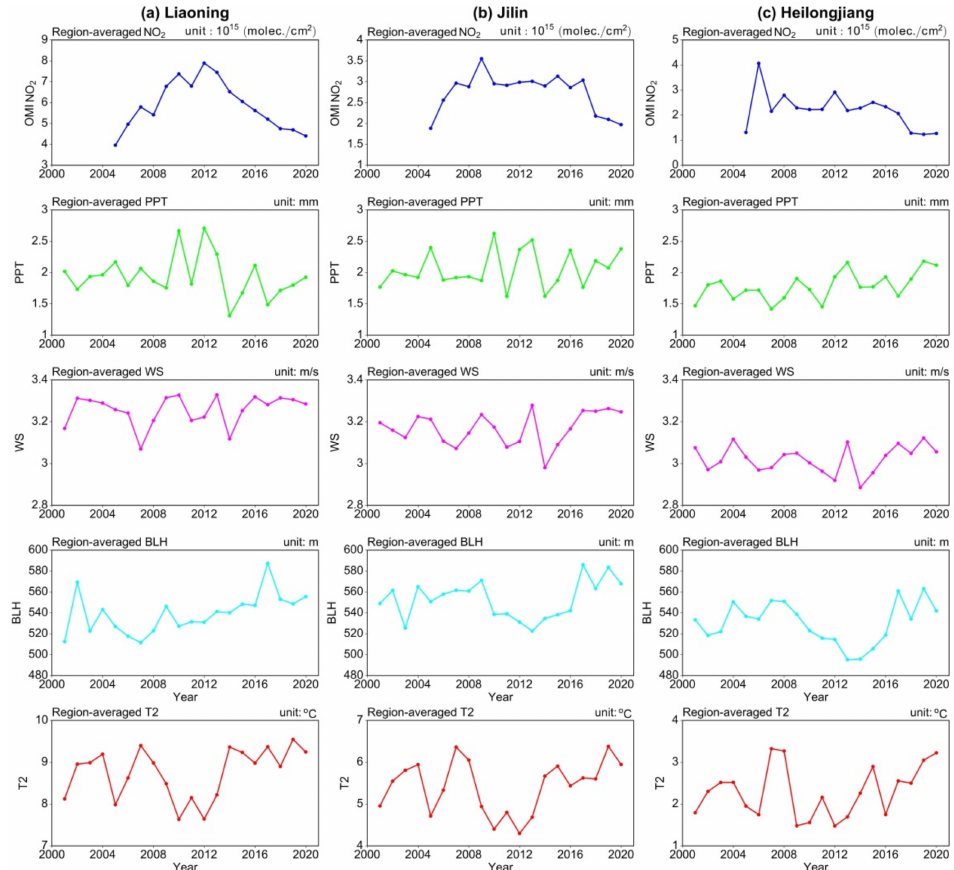
Figure 9. Interannual variation of region-averaged tropospheric NO 2 columns, precipitation (PPT), wind speed (WS), boundary layer height (BLH), and temperature at 2 m (T2) in ( a ) Liaoning, ( b ) Jilin, and ( c ) Heilongjiang in NEC. Note that tropospheric NO 2 columns data are available for the years